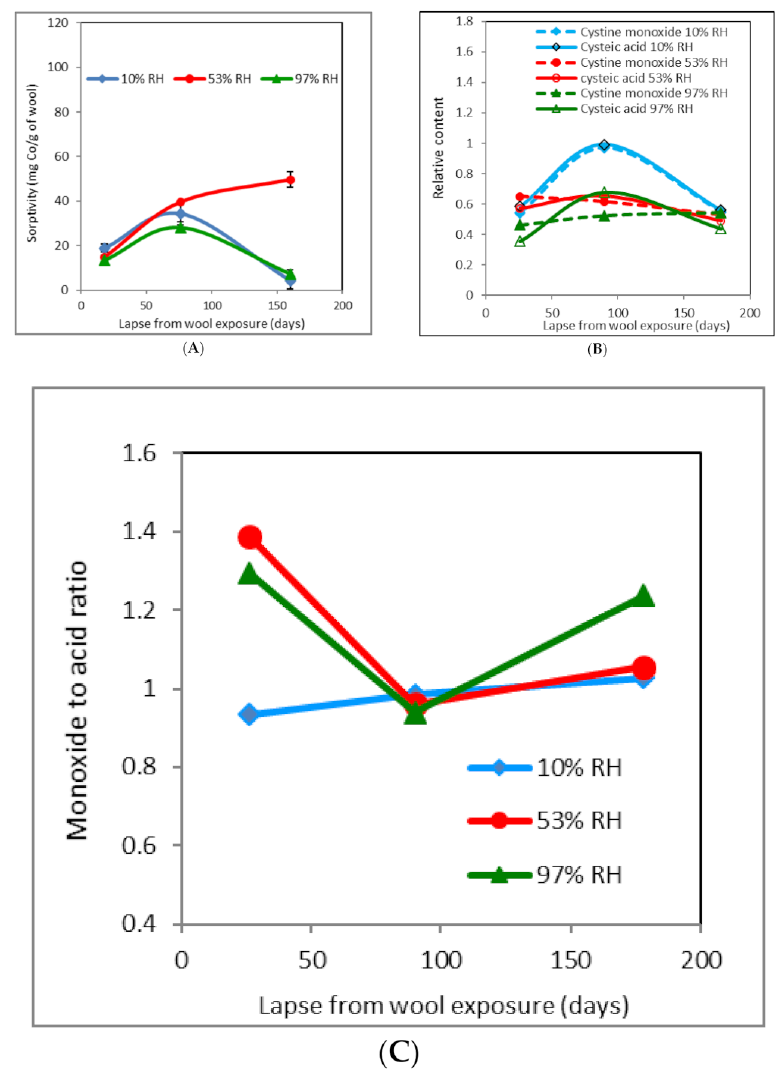
Figure 2. Time development of sorptivity ( A ), relative content of cysteic acid and cystine monoxide ( B ), and cystine monoxide to cysteic acid ratio ( C ) for non-irradiated wool pre-conditioned at different RH. Measurements were performed after subsequent storage under laboratory